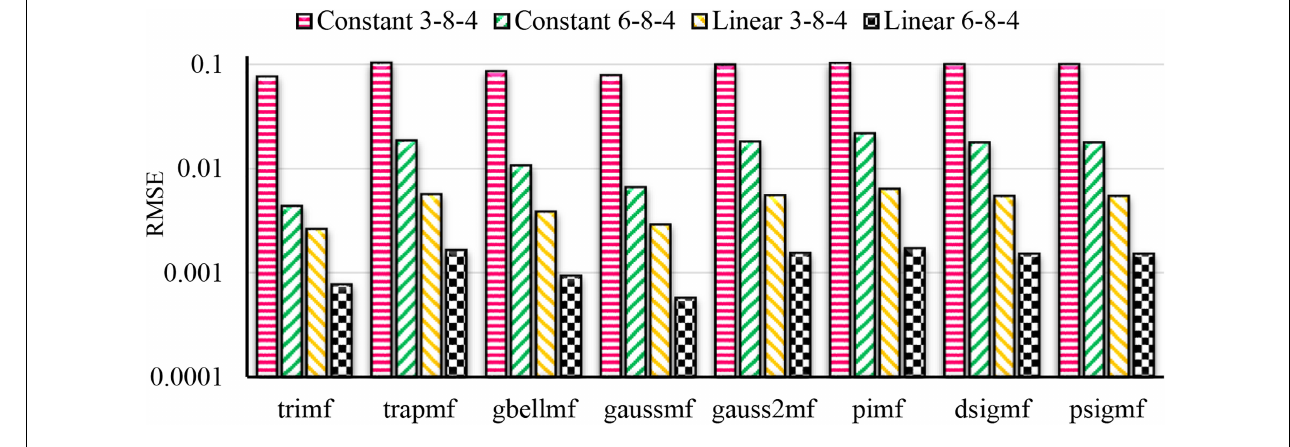
FIGURE 7 | RMSE of ANFIS model.